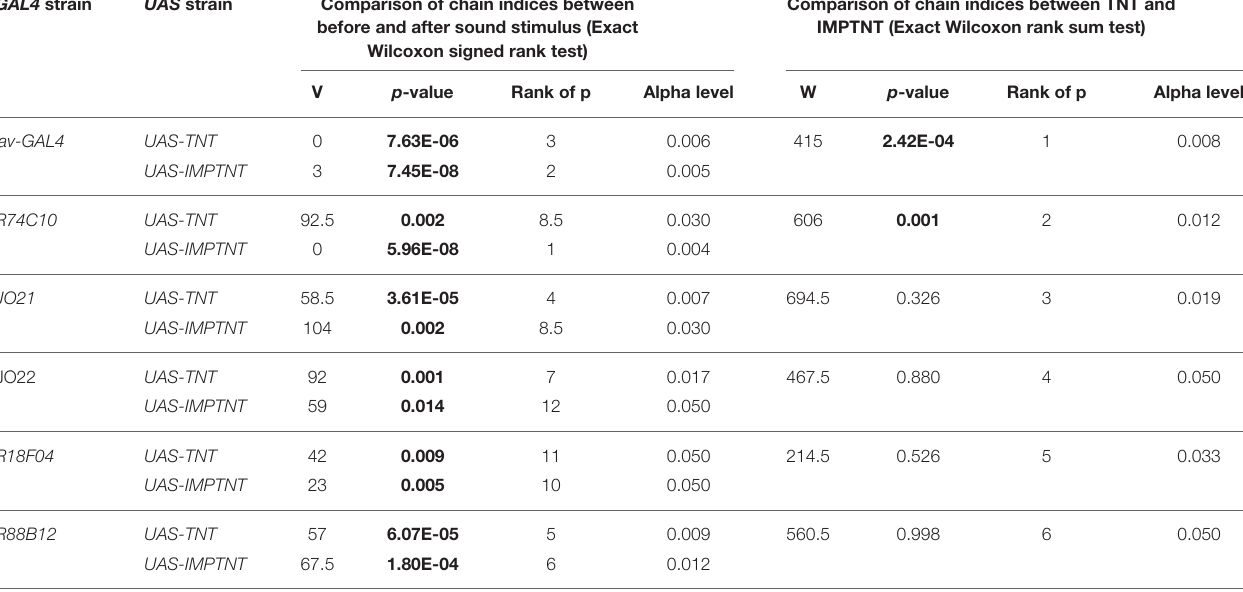
TABLE 7 | Statistics of chain index in GAL4 > TNT males. GAL4